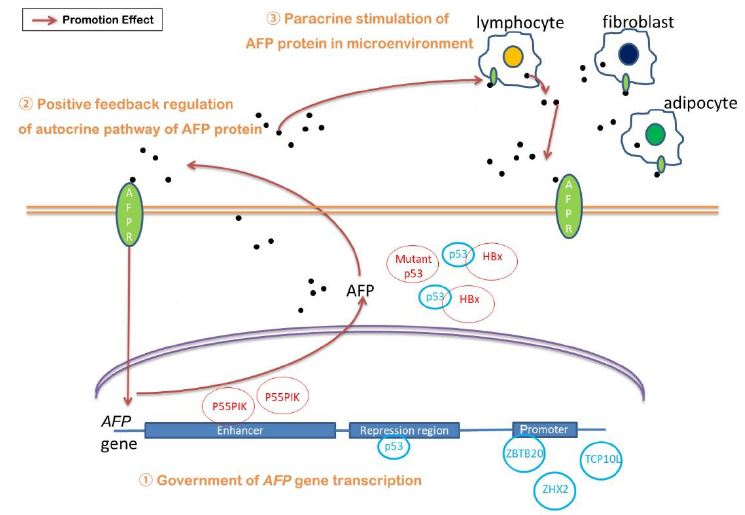
Figure 1. Regulatory mechanisms of AFP expression. ( 1 ) Government of AFP gene transcription, ( 2 ) positive feedback regulation of autocrine pathway of AFP protein and ( 3 ) paracrine stimulation of AFP in microenvironment.